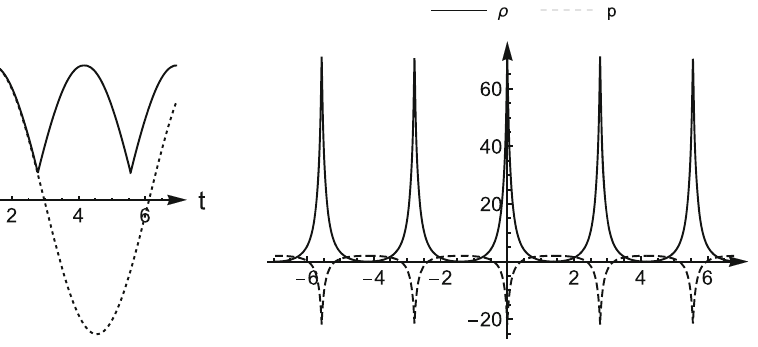
Fig. 3 A cyclic universe due to the time-crystal mechanism is depicted by the solid line of the left plot ( a 0 = 1, A = 5, (cid:14) = 1, k = − 1, cor- responding to (cid:9) = − 3 and α = 5.) The dotted sinuous line is an exact